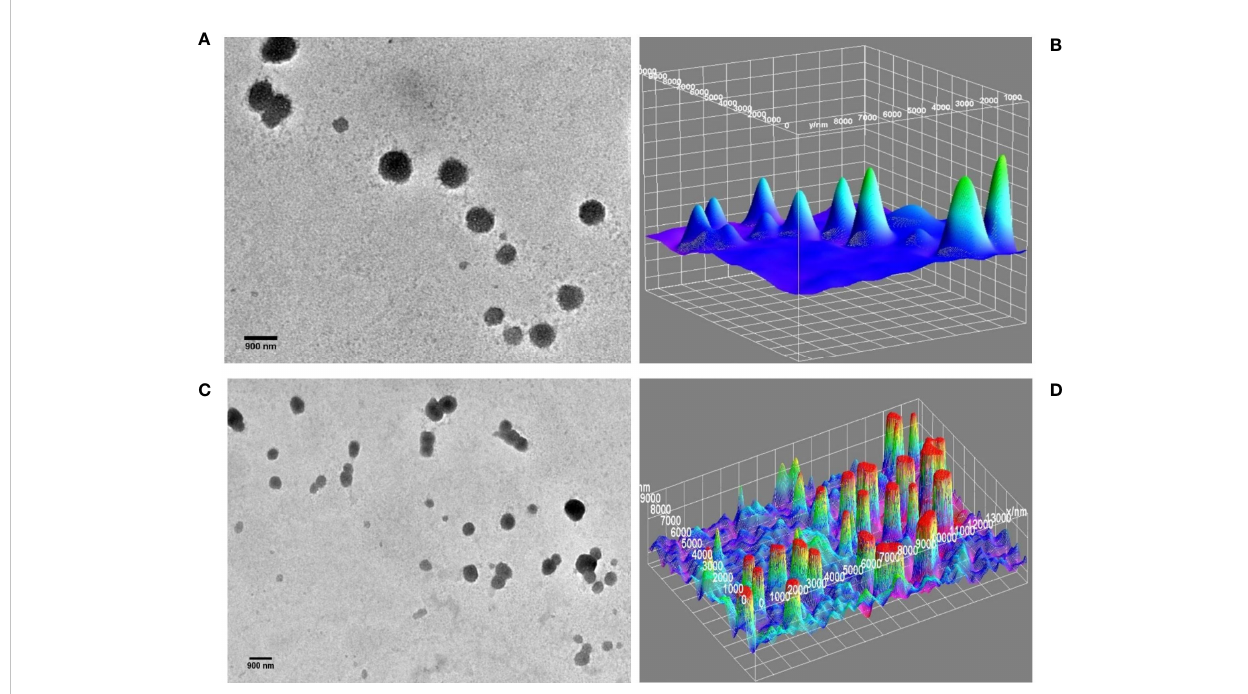
FIGURE 4 TEM image of DTIC-SLNs-10; without Kolliphor ® (A) with 3D surface morphology (B) . TEM image of DTIC-SLNs-11; without phosphatidylcholine (C) with 3D surface morphology (D)